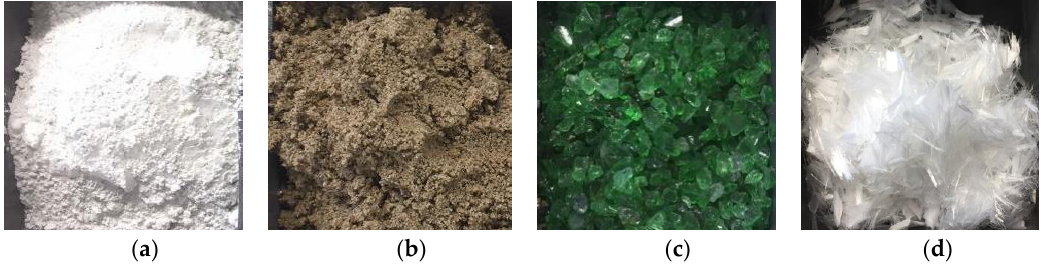
Figure 2. Components used in the experimental campaign. ( a ) Cement; ( b ) Fine aggregate; ( c ) Coarse aggregate (recycled glass); ( d ) Fibers.